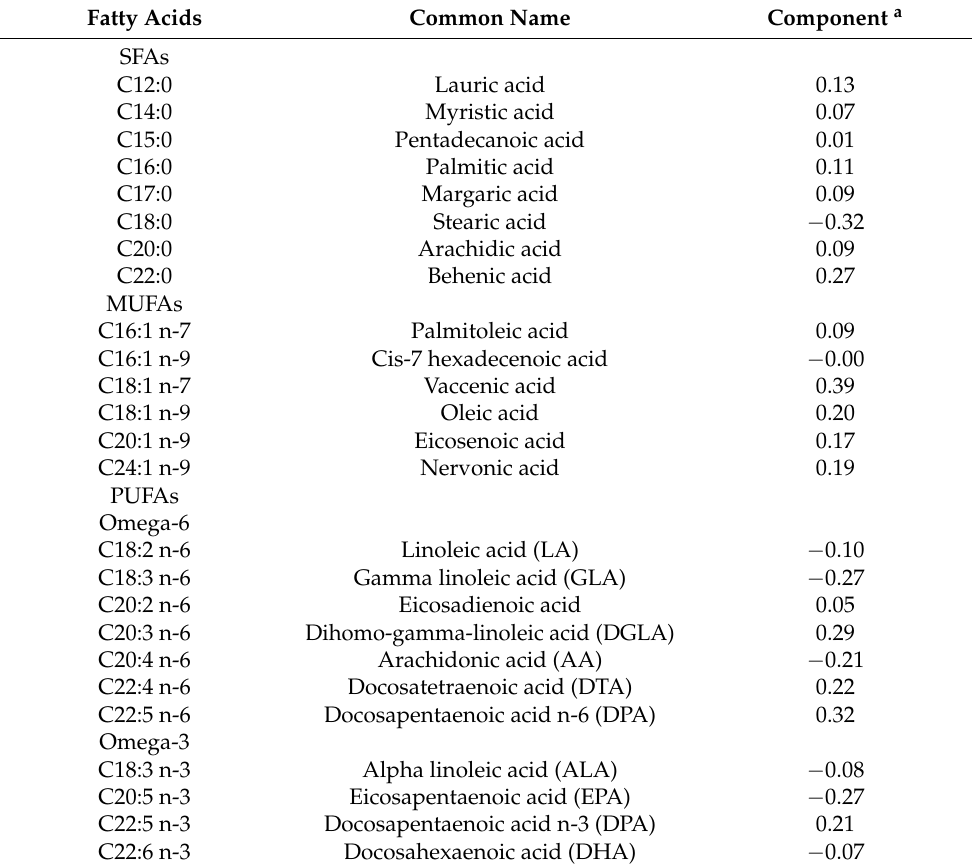
Table 4. Factor weight values of plasma fatty acids obtained by the partial least squares regression generalized linear models associated with the presence of dry eye disease in the Montrachet Study.